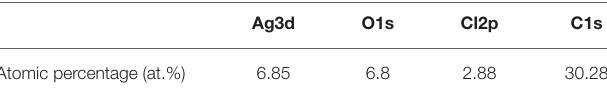
TABLE 1 | Atomic percentage of Ag/AgCl wire determined from X-ray photoelectron spectroscopy (XPS) survey spectra after galvanostatic polarization and immersion in 1M hydrochloric